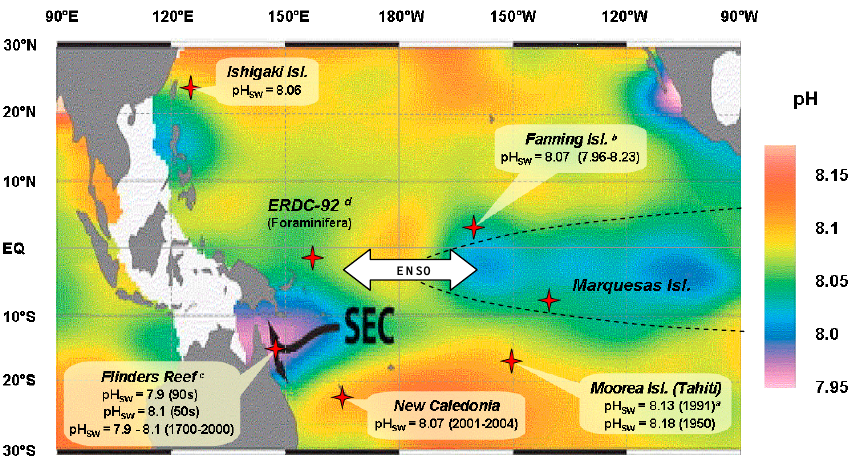
Fig. 1. Geographical locations of the study sites, including Moorea (close to Tahiti), Marquesas, Ishigaki, New Caledonia and the Fanning Islands. The location of the ERDC-92 box core (Palmer and Pearson, 2003) is also shown. The sea surface pH from modern corals are plotted on a seawater scale pH map modified from Pelejero et al. (2005). The δ 11 B data of corals: (a) Gaillardet and All`egre, 1995; (b) Hemming et al., 1998; (c) Pelejero et al., 2005; the foraminifera δ 11 B data: (d) Palmer and Pearson,